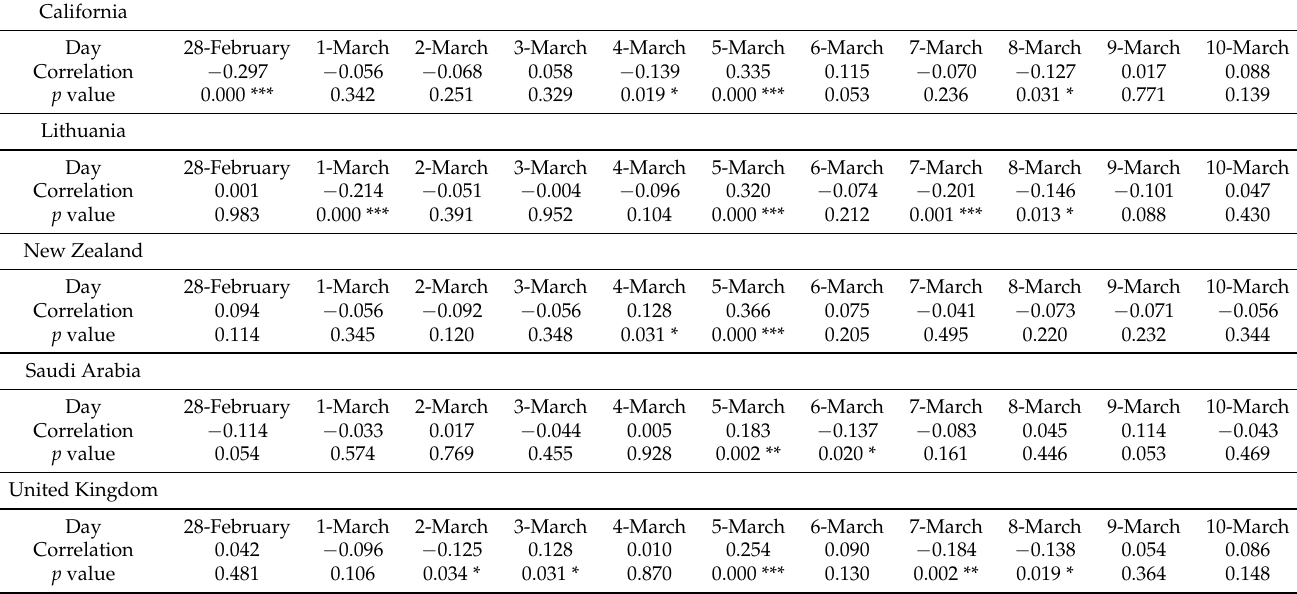
Table 3. Results of the correlation coefficient statistical significance test (* p < 0.05, ** p < 0.01, *** p < 0.001). It can be noted that mean LMF-HRV-synchronization on day 6 (HLI day) was significantly different from zero for all five groups.